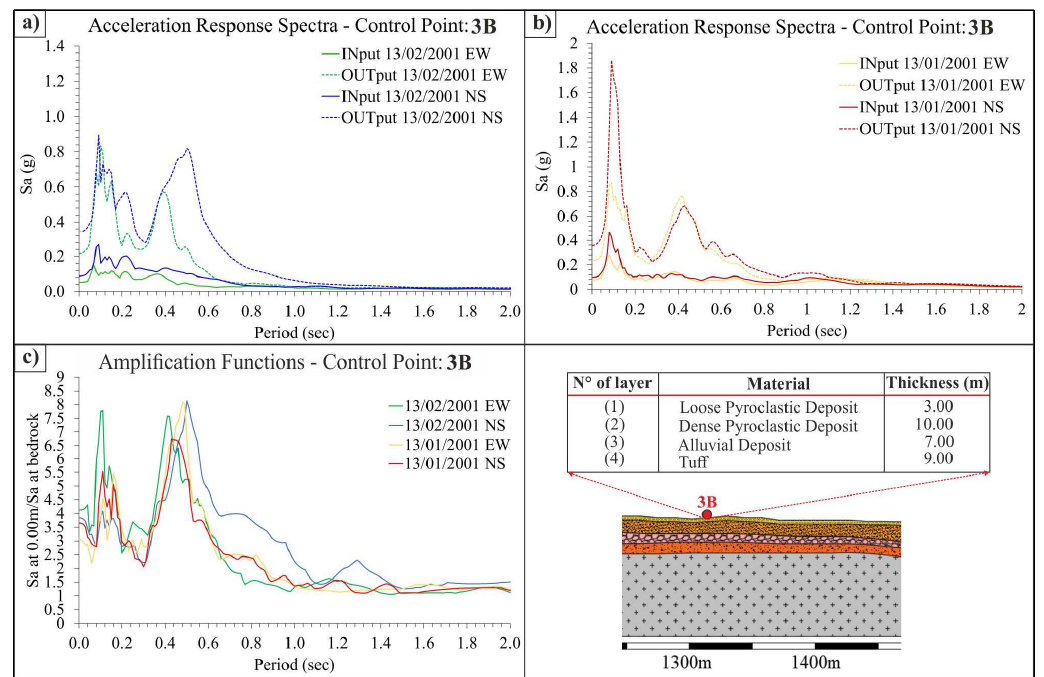
Figure 20. Section BB′: numerical control point 3B spectral responses obtained by 2D numerical analyses using LSR2D software. ( a ) Comparison among the SA of the two components of the 13 February 2001 earthquake. ( b ) Comparison among SA of the two components of the 13 January 2001 earthquake. ( c ) Amplification functions related to the four input motions.